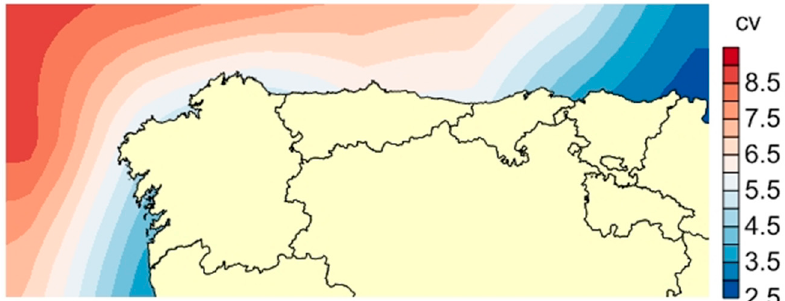
Figure 4. Scale of the offshore wind parameter for the North of Spain.